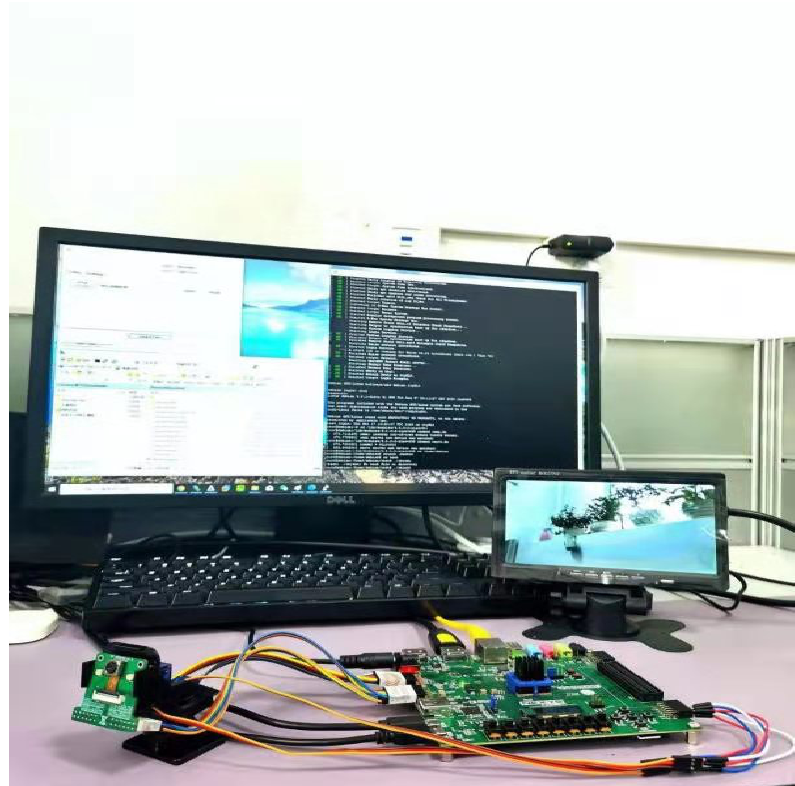
Figure 4. Experimental operating environment.